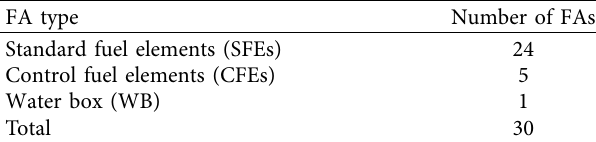
three regions. Region 1 is home to 6.275 cm × 8.10 cm